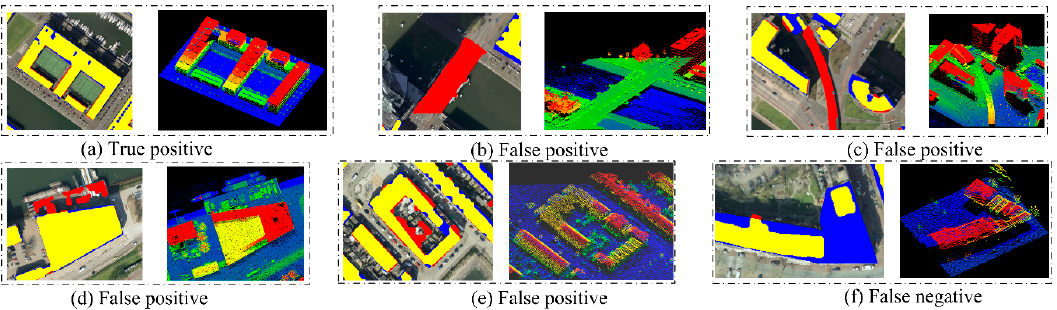
Figure 9. Six examples of the building detection results for Rotterdam data.